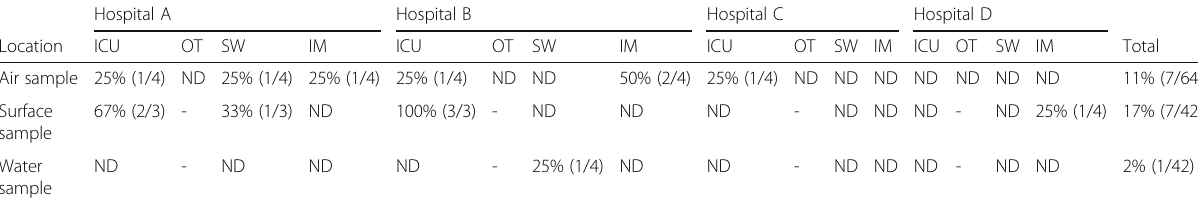
Table 3 Percentage (No. of positive samples/total samples in each ward) of A. baumannii positive environmental samples in different hospital wards